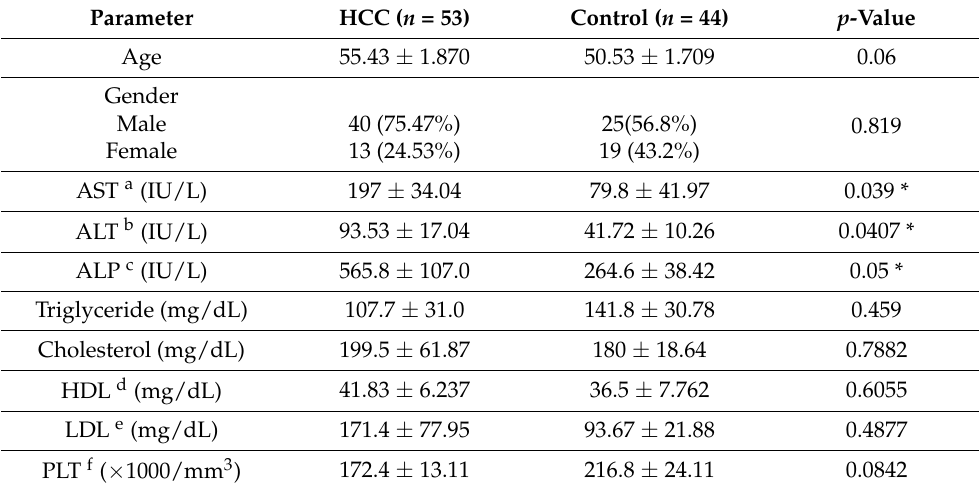
Table 2. Demographic characteristics and laboratory findings of the study